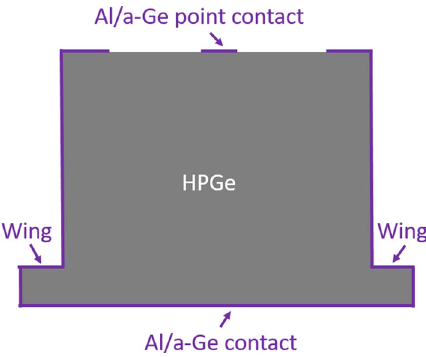
Fig. 2 Cross-sectional drawing of a planar PPC Ge detector. The point and outer surface contacts are in purple and they are both made of a-Ge contact with Al on the